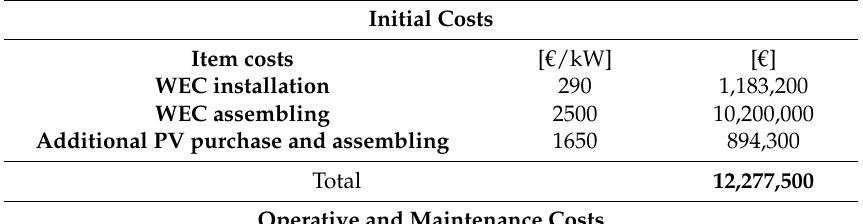
Table 4. Initial cost items, operative, and maintenance costs of the wave farm.